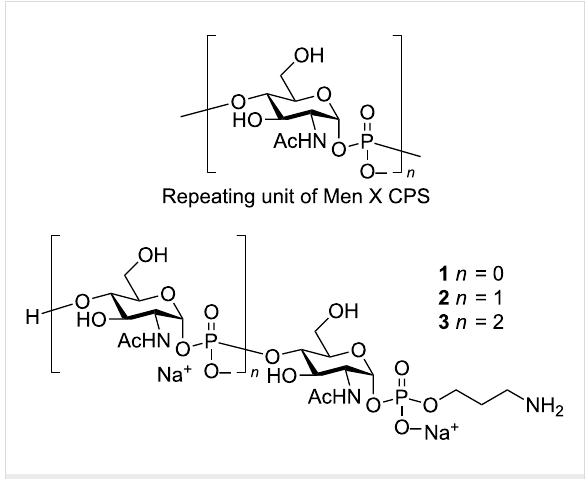
Figure 1: Structures of the repeating unit of MenX CPS and synthetic oligomers 1–3